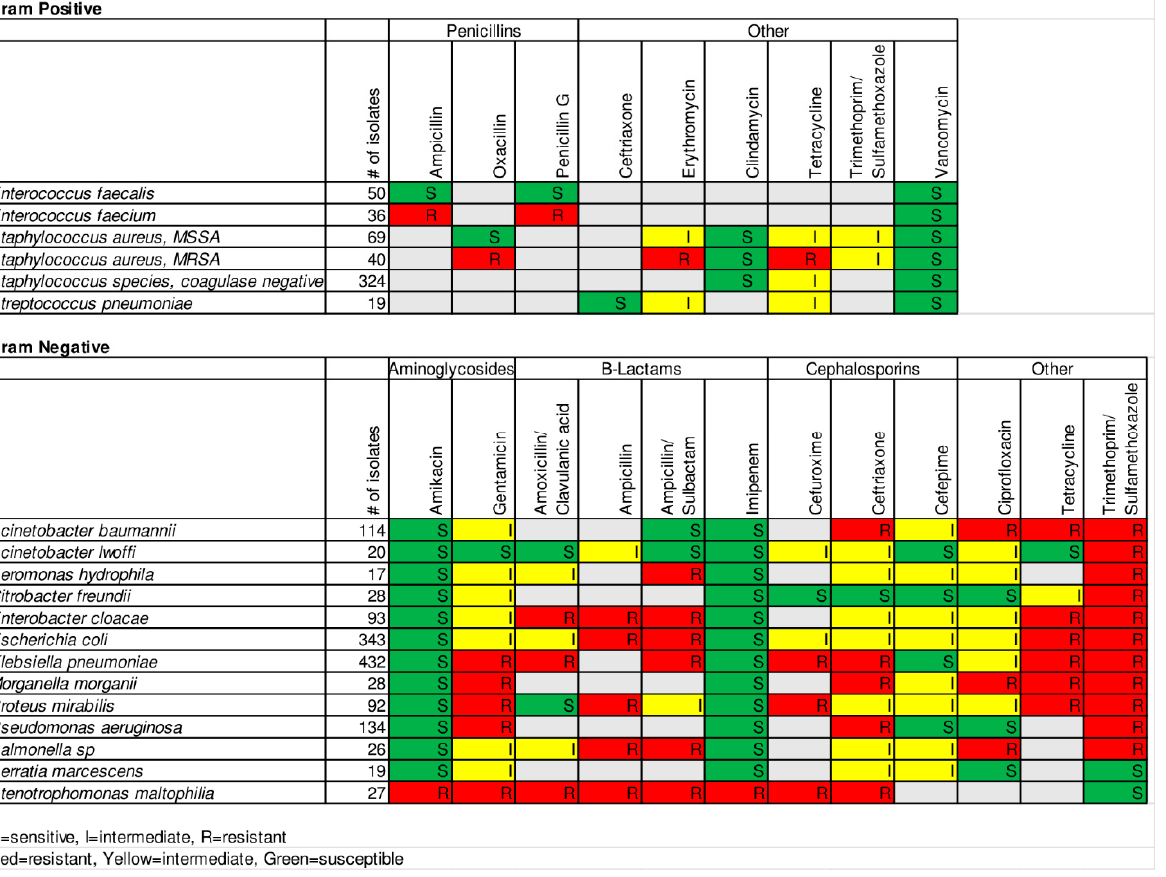
Figure 2. UTH antibiogram for general practitioners.